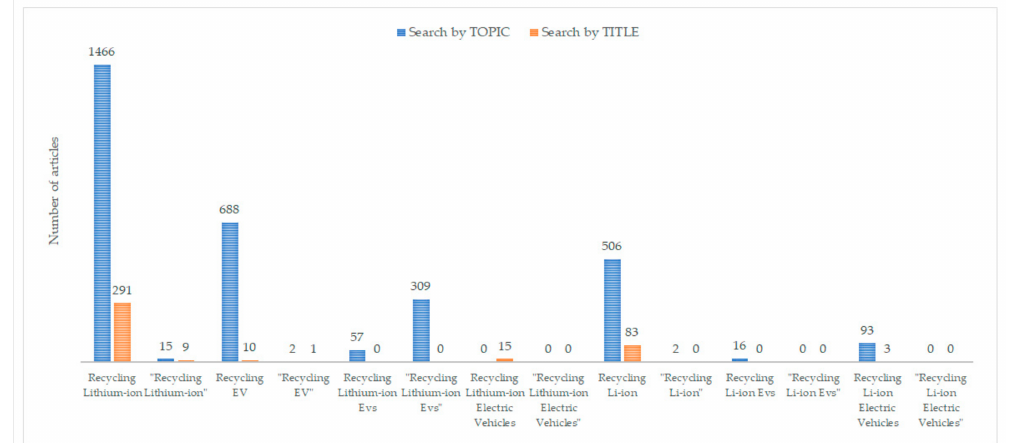
Figure 1. The main search on WoS, the number of searched articles of individual search terms.